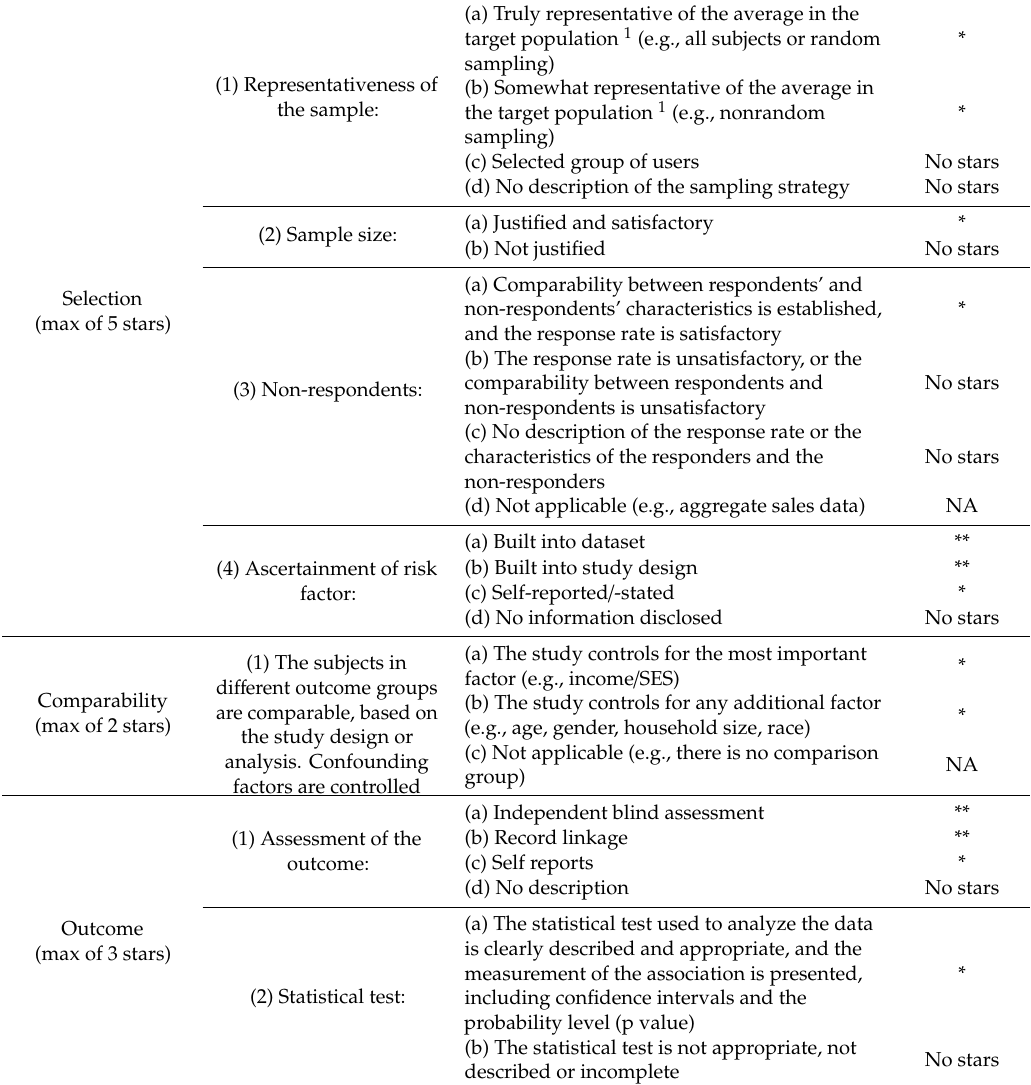
Table A1. Newcastle–Ottawa quality scale adapted grading